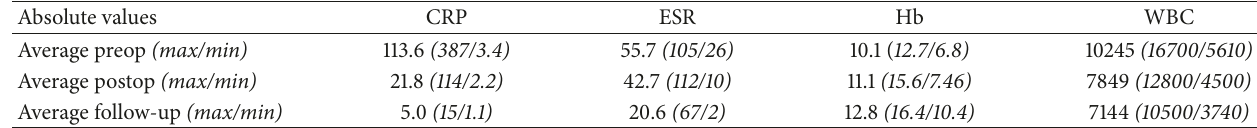
Table 2: Absolute values of biochemical parameters.